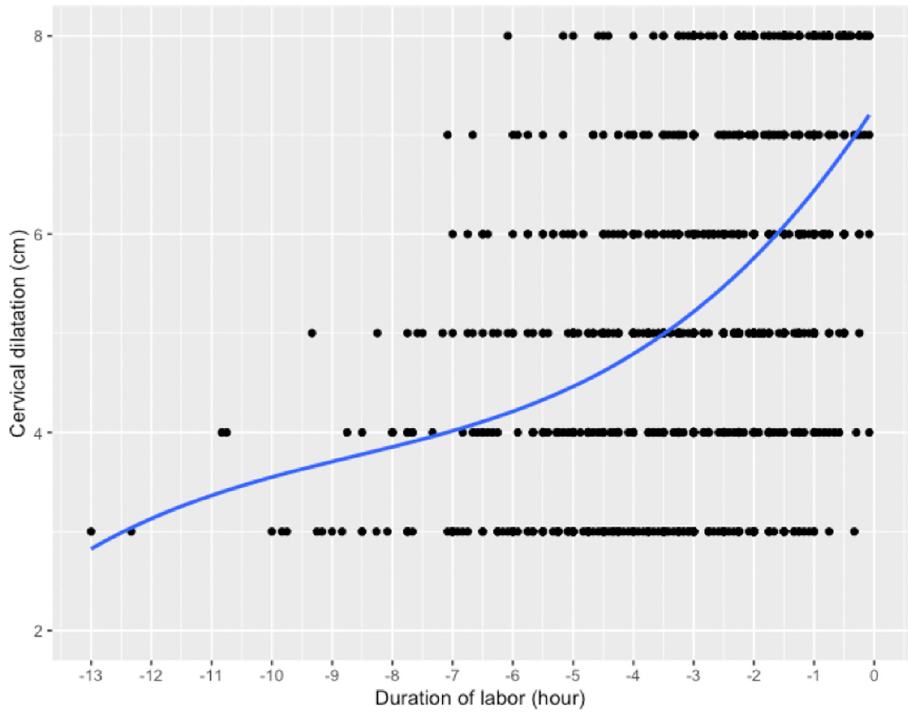
Fig 2. Cervical dilatation curves of breech presentation with spontaneous labor and vaginal deliveries.